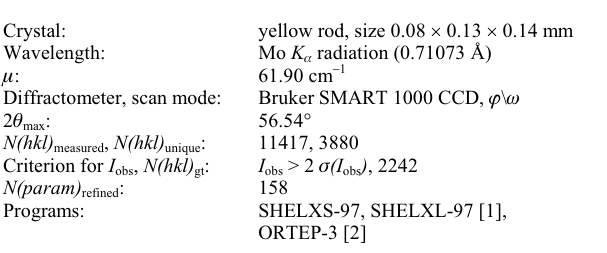
Table 1. Data collection and handling.